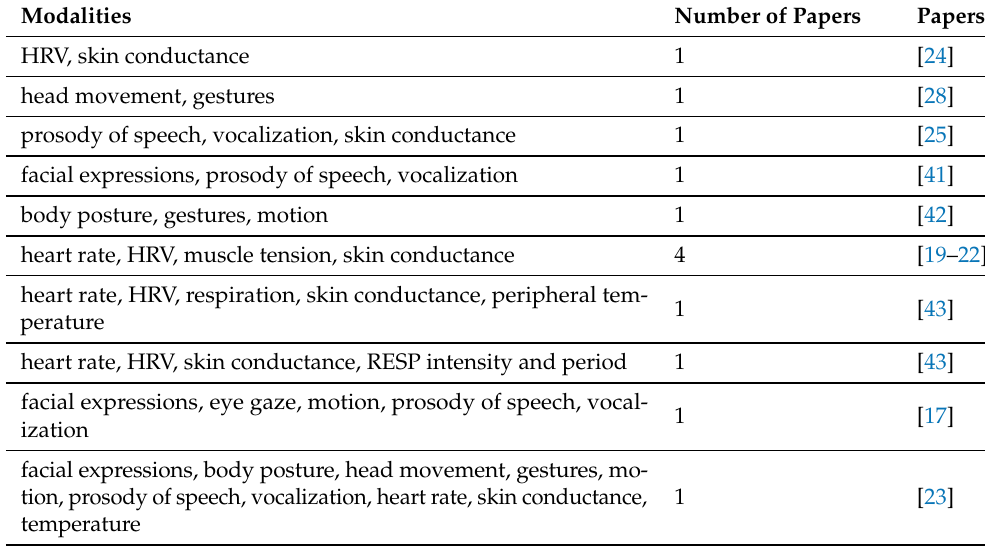
Table 13. Modalities analyzed